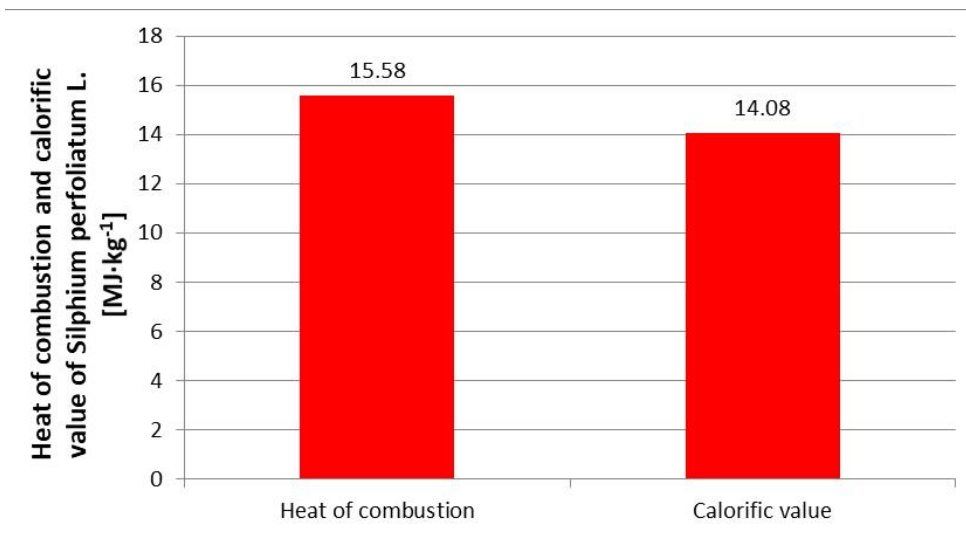
Figure 11. The heat of combustion and calorific value of Silphium perfoliatum L. at a moisture content of 7.15%.